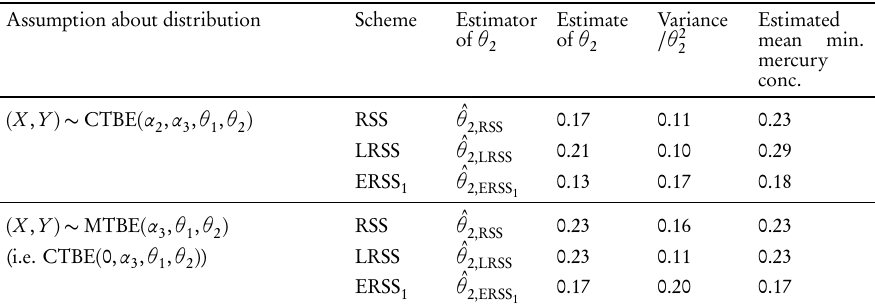
Estimate of θ under different RSS schemes for bivariate 2